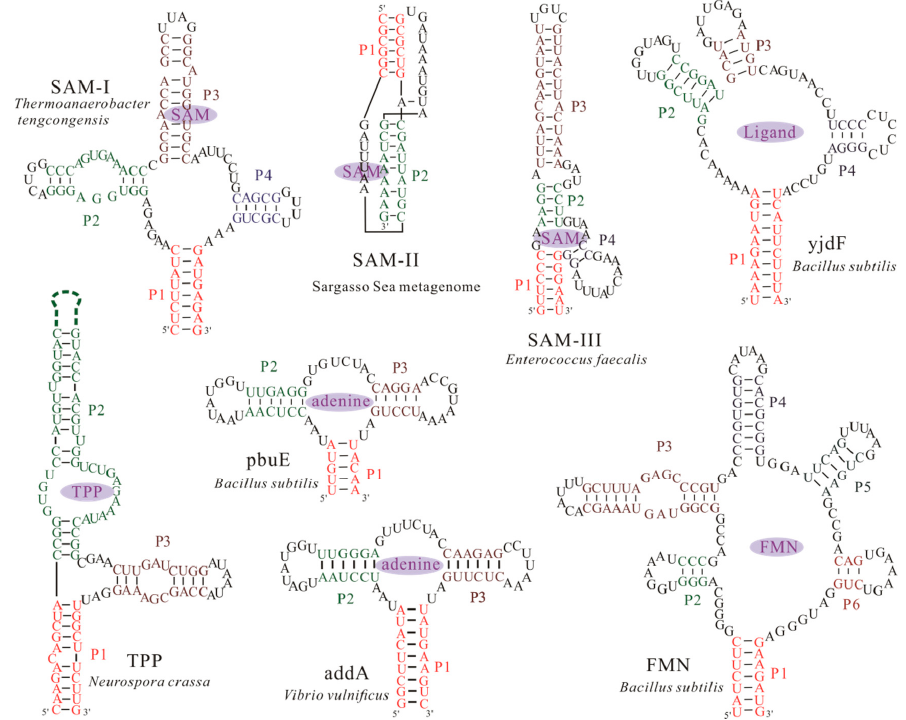
Figure 1. Structural models of aptamers from several extensively studied riboswitch candidates.